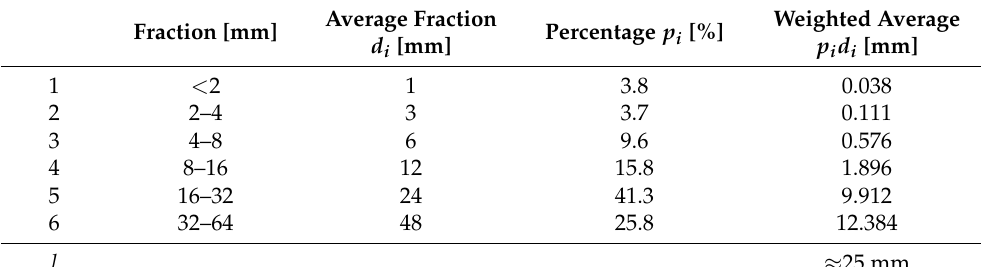
Table 1. Calculation of weighted average (average particle diameter) based on the grain-size